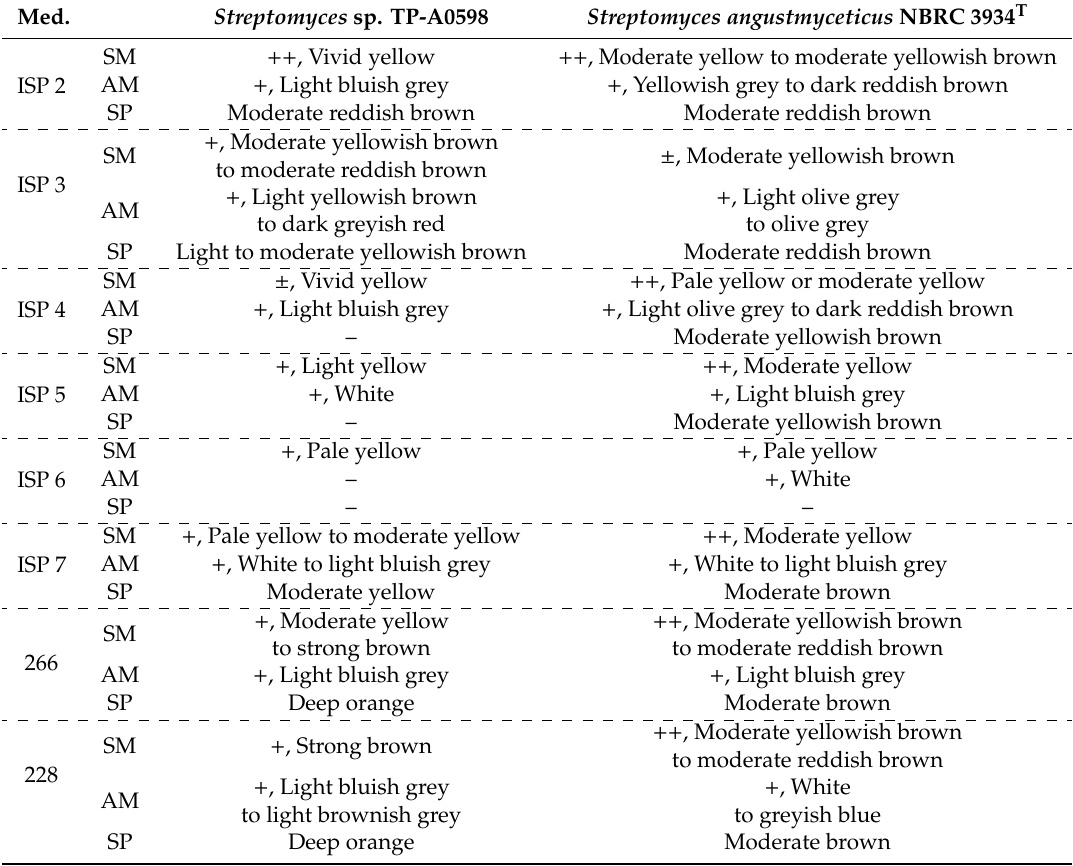
Table 1. Cultural characteristics of Streptomyces sp. TP-0598 and the type strain of its closest phylogenetic